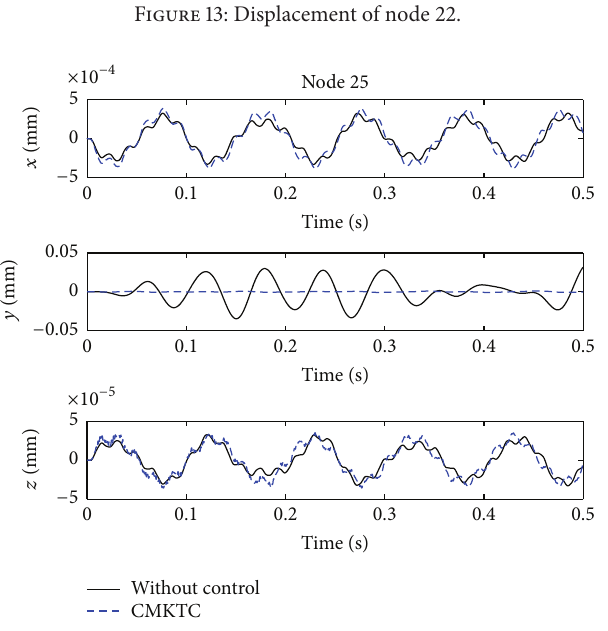
Figure 13: Displacement of node 22.